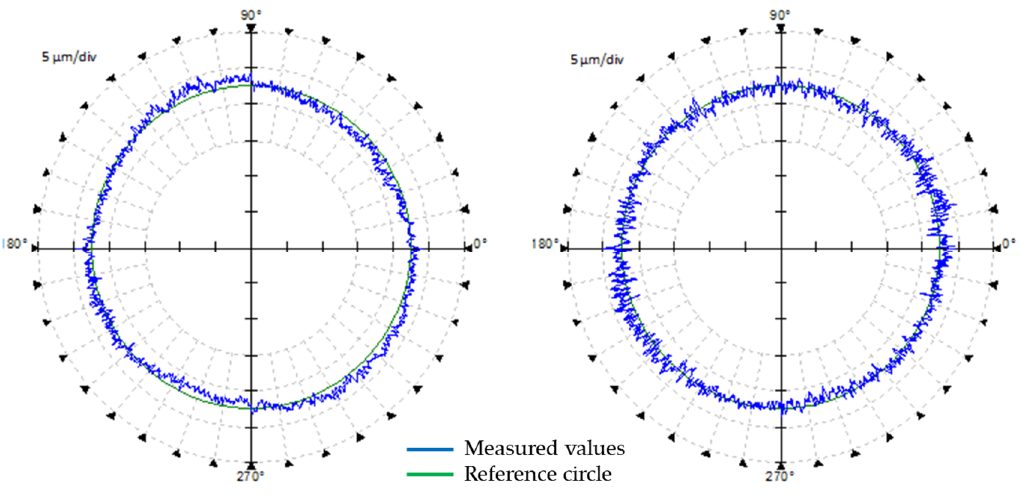
Figure 17. 100 mm outer diameter for TH1 and TH2 in position 04.